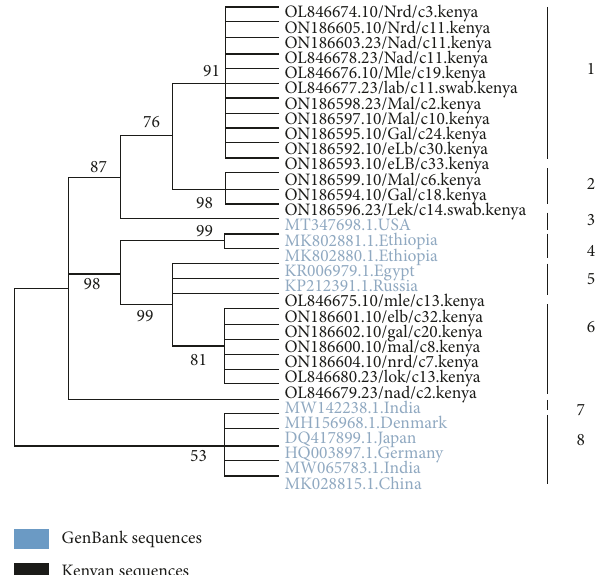
Figure 2: A phylogenetic tree based on the kmt1 gene was inferred by using the maximum likelihood method and Tamura–Nei model. The tree obtained by neighbor-join and BioNJ algorithms to a matrix of pairwise distances estimated using the Tamura–Nei model. Phylogeny was tested with 1000 bootstrap replications. Evolutionary analyses were conducted in MEGA X version 10.1 software. Numbers indicate clades. Bootstraps are shown at the